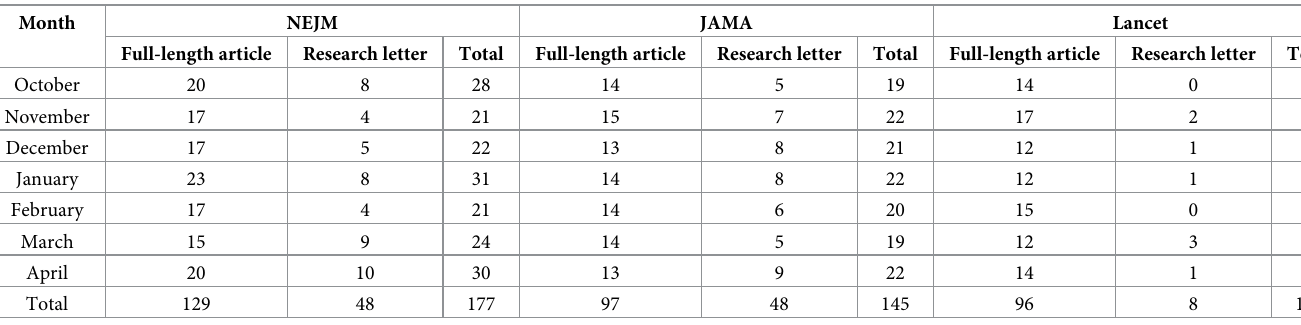
Table 1. Distribution of research article type by